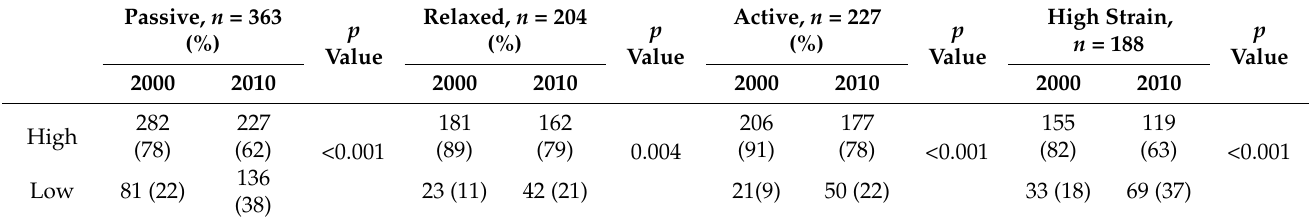
Table 2. Social participation at baseline and follow-up, in four job type groups, p values for change in social participation between 1999 and 2010, n = 982. Passive, n =